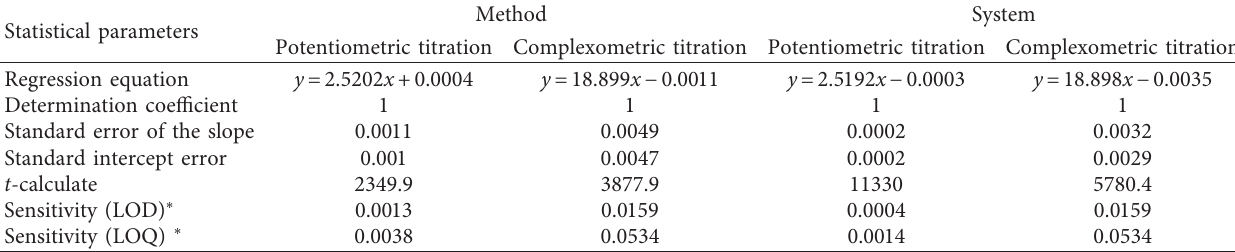
Table 1: Linearity and sensitivity of the methods studied.